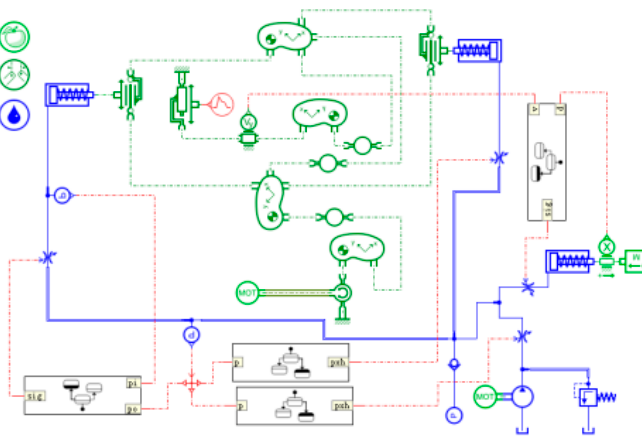
Figure 5. Advanced Modeling Environment for performing Simulation of engineering system AMESim simulation model of variable compression ratio (VCR) system.